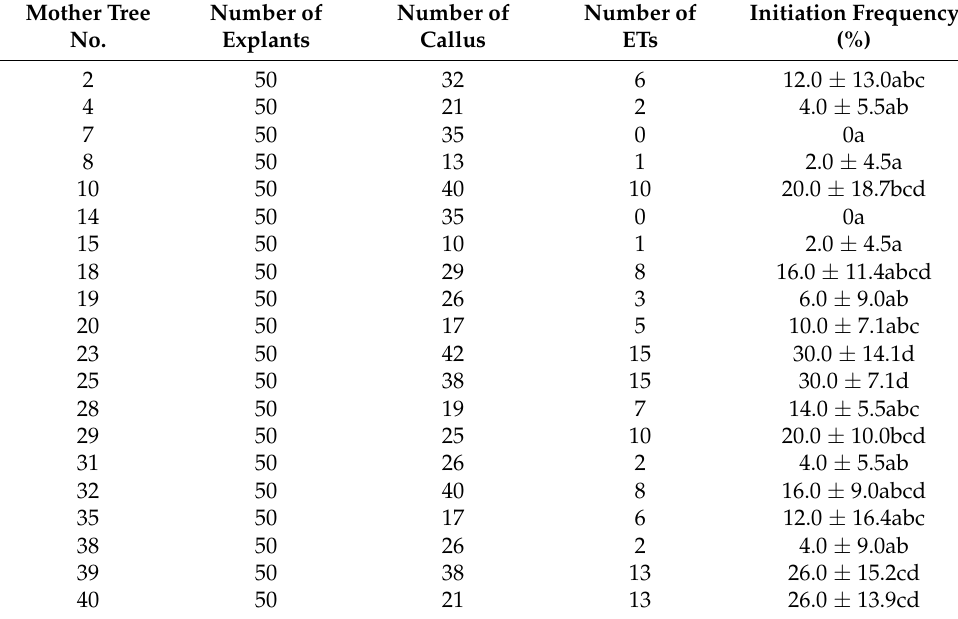
Table 1. Effects of mother trees on ETs induction in L. principis-rupprechtii Mayr. Mother Tree